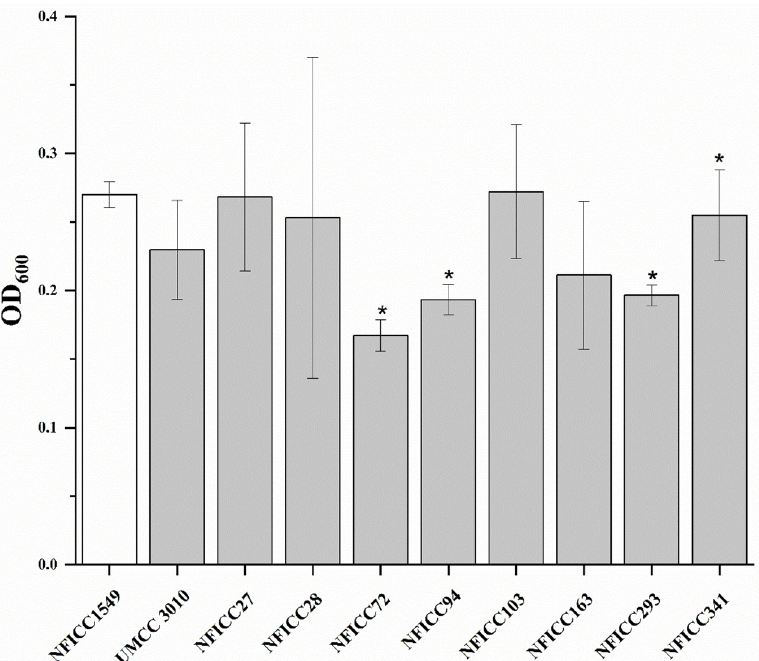
Figure 6. Antibacterial activity of the selected LAB’s cell-free supernatant in Bread Medium (BM) on spoilage agent B. licheniformis NFICC1549. One-tail t -test was performed on the obtained tripli- cates comparing OD 600 value after 48 h growth of NFICC1549 in BM and the same spoilage agent challenged with CFS of L. plantarum (NFICC27, 72, 163, and 293), Lc. citreum (NFICC28 and 94), and P. pentosaceus (UMCC 3010 and NFICC341). The * indicate measurements that are significantly dif- ferent, with a mean lower than the control samples; t(2) = − 2.92, p =0.05.